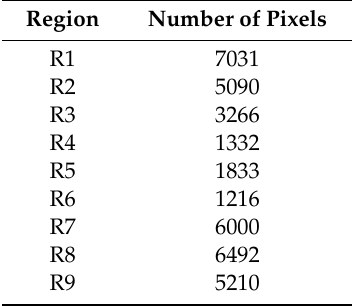
Table 2. Seasonally homogeneous regions with the respective number of